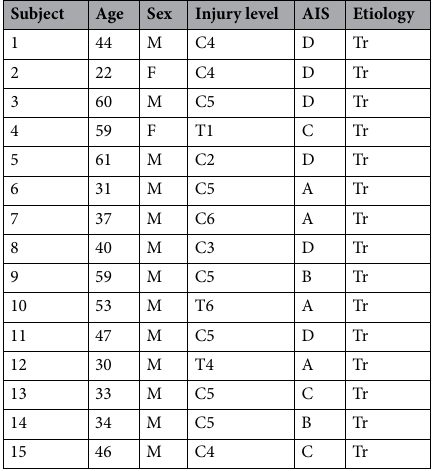
Table 1. Demographic and injury characteristics. AIS American Spinal Injury Association Impairment Scale; M male; F female; C cervical; T thoracic; Tr